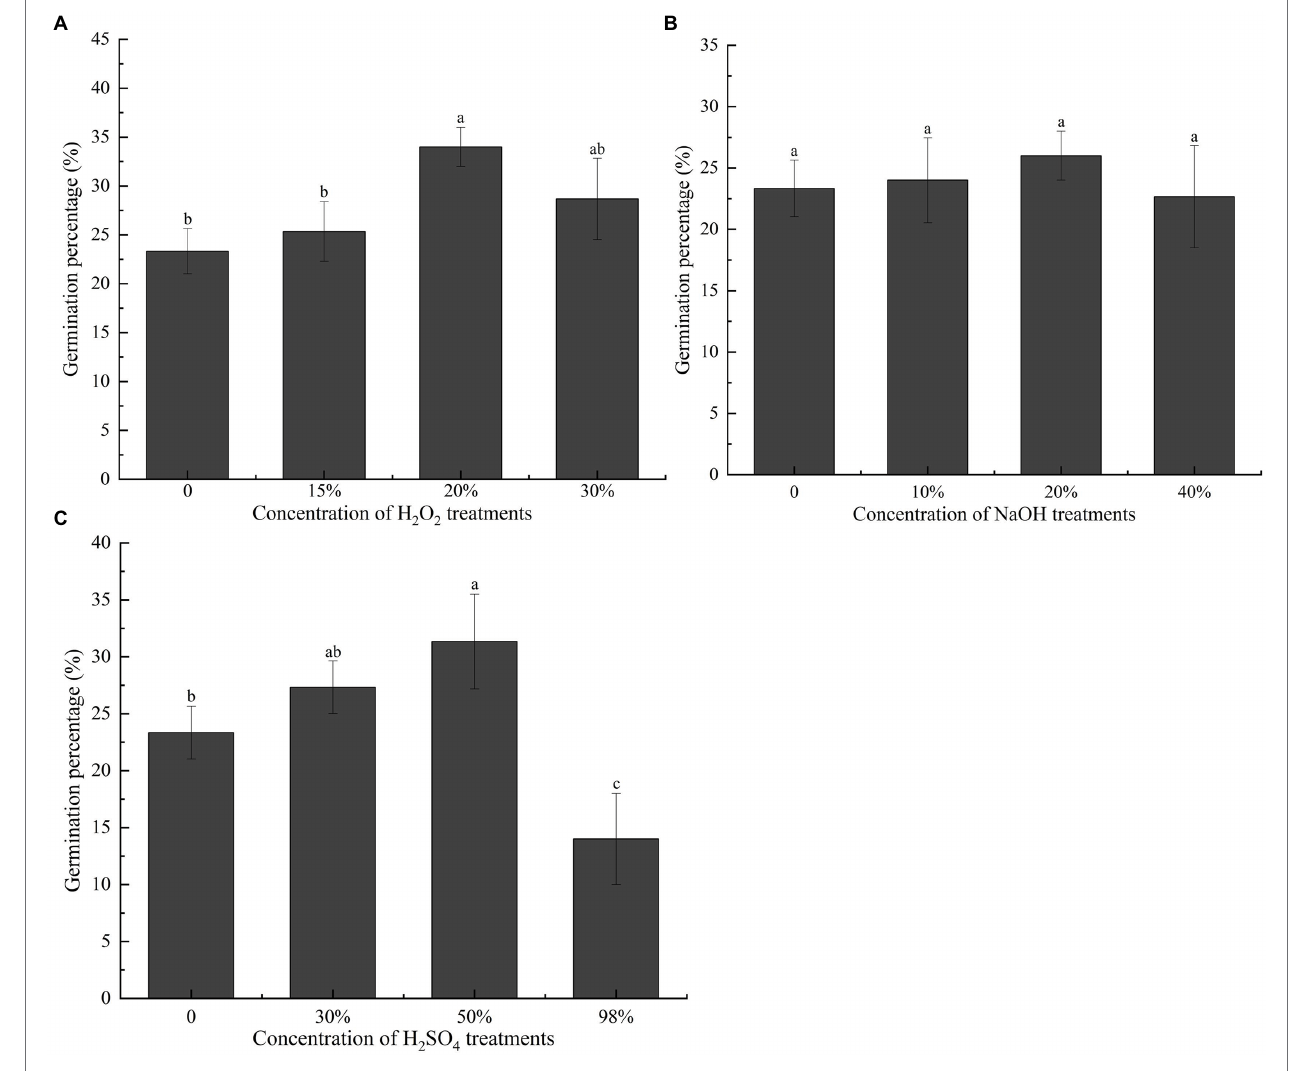
FIGURE 4 | Effect of different chemical treatments on the final germination percentage of Cinnamomum migao seeds. Data are presented as means ± standard deviations ( n = 3), and the values marked with different letters in various treatments vary significantly at p < 0.05. Three replicates of 50 seeds each were used for each treatment. (A) Different concentration of H 2 O 2 treatment germination percentage of C. migao seed, (B) different concentration of NaOH treatment germination percentage of C. migao seed, (C) different concentration of H 2 SO 4 treatment germination percentage of C. migao